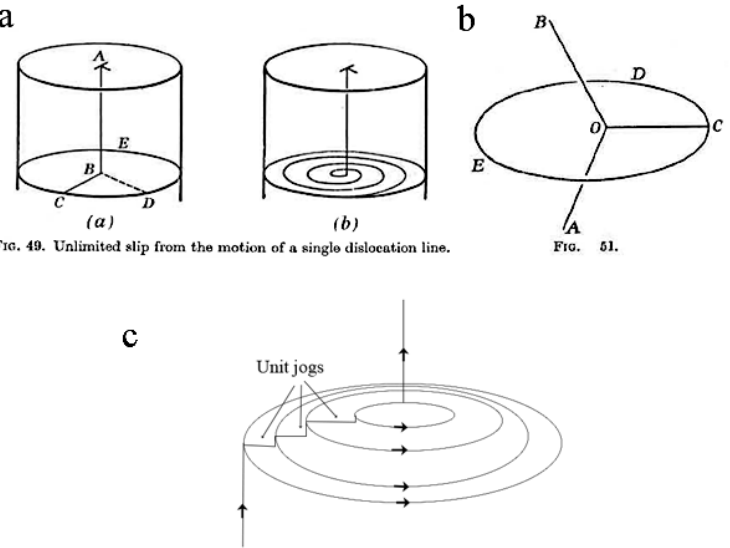
Figure 10. Schematic representation of twinning dislocations and pole mechanism. ( a ) An early model made by Frank and Read explains the dislocation “multiplication” in a crystal, from Cottrell’s book [54]; ( b ) this model was used by Cottrell to explain how dislocations can build twins; ( c ) Scheme of the pole mechanism proposed by Venables, adapted from [73].